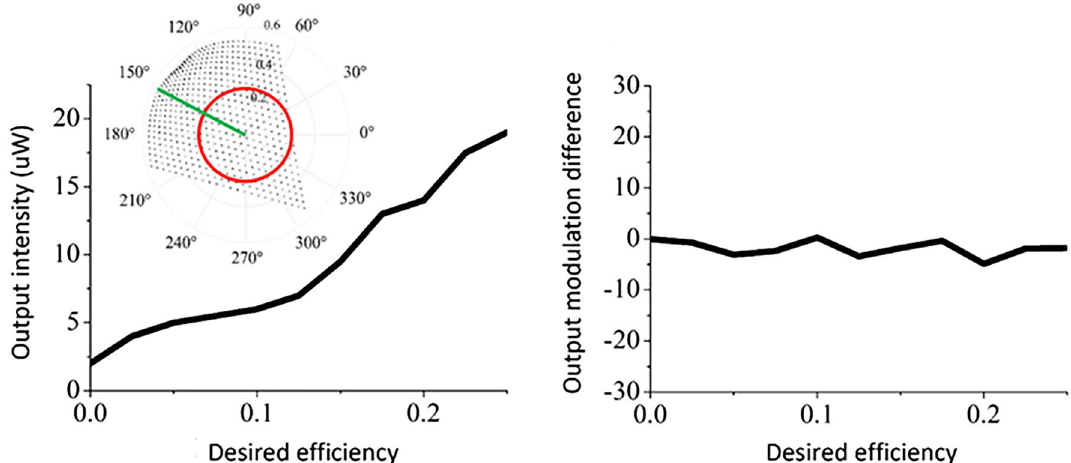
Figure 5. The observed output intensity (left panel) and phase variation (right panel) of the dual-layer IPS-LC SLM at the measurement of amplitude modulation. The inset image shows the straight-lined modulation path of this experiment presenting the amplitude-only modulation